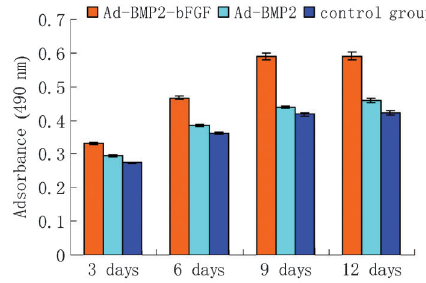
Figure 4. Effect of infection on the viability of bone marrow progenitor cells (BMPCs). BMPCs were infected with Ad-BMP2- bFGF or Ad-BMP2 and cell viability was determined by MTT assay (n=3).